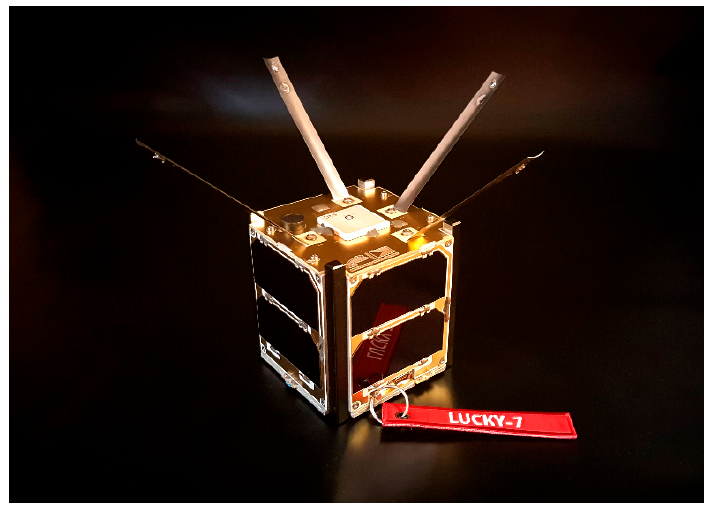
Figure 1. Lucky 7 CubeSat.